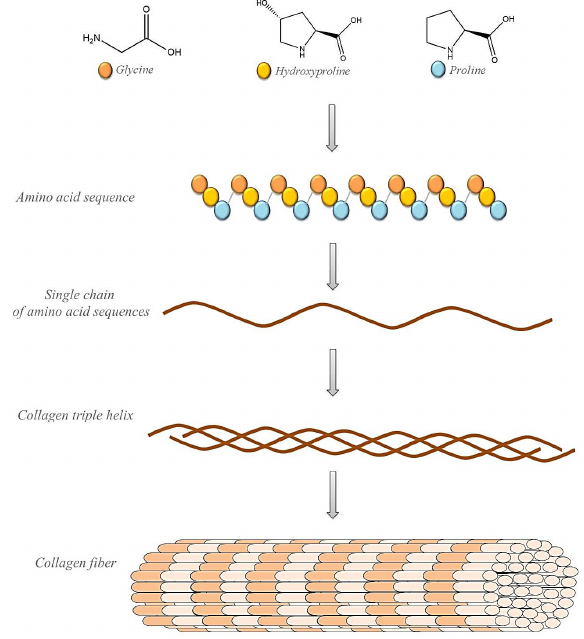
Figure 2. Schematic representation of collagen’s structure.